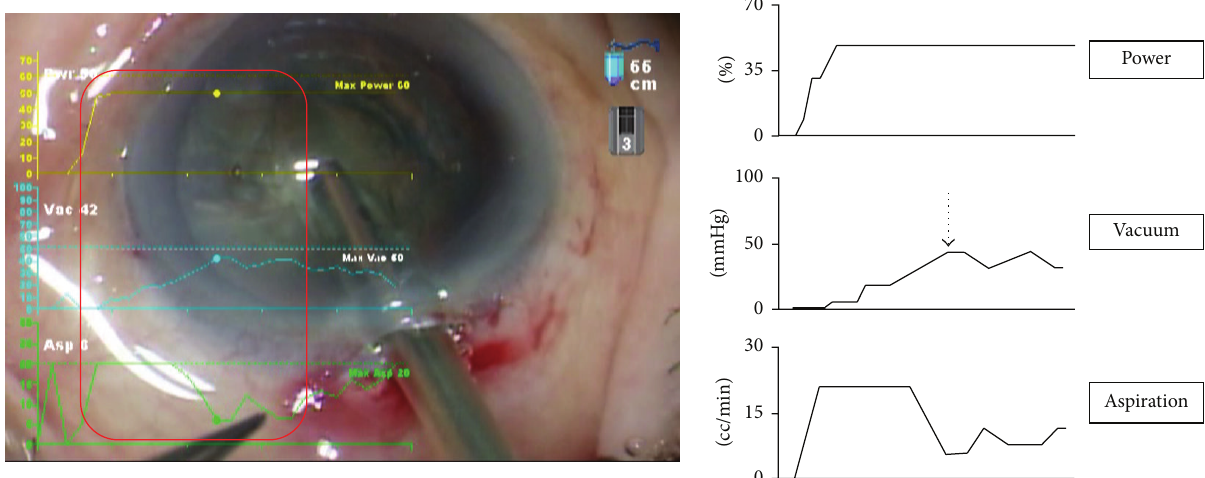
Figure 6: Case 3, trenching performed by trainee